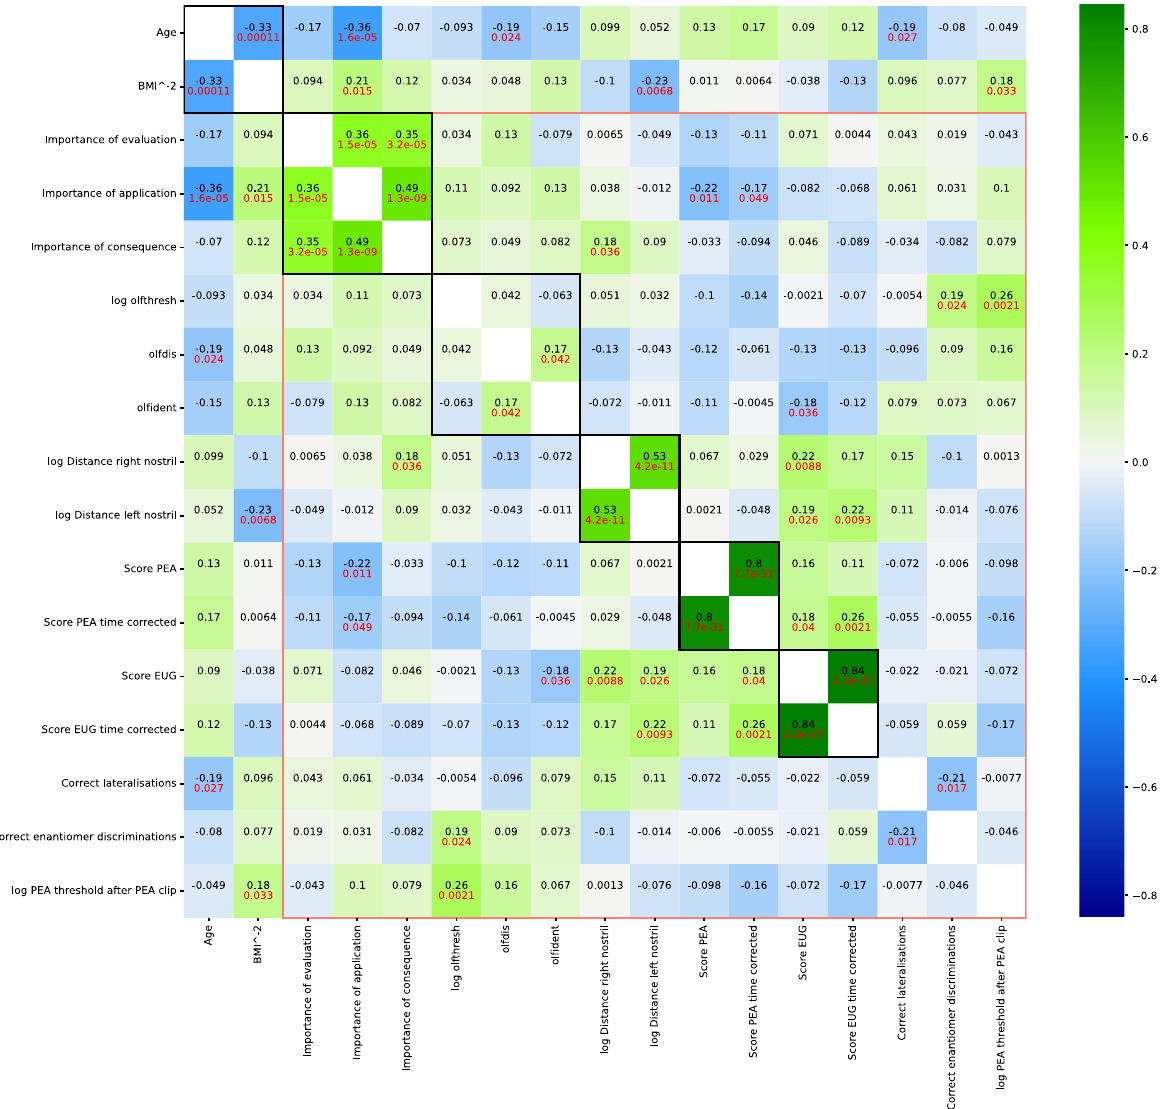
Figure 3. Correlations of olfaction-related data collected from n = 135 subjects, transformed to normal distribution and with missing values imputed. Age and BMI were additionally included. The correlation matrix is color-coded according to the strength and direction of the correlation. Each cell is labeled with the value of Pearson’s r in black numbers. If the correlation is significant, the p-value is indicated in red numbers below the correlation coefficient. The diagonal of the cor- relations of each variable with itself has been omitted. Variables belonging to the same subtest are highlighted by black rectangles to increase distinction of intra- and intertest correlations. Olfactory variables are outlined in red. Variable names, if not self- explaining: “olfthresh“ = olfactory thresh- old to phenyl ethyl alcohol (PEA), “olfdis” = score in the odor discrimination task, “olfident” = score in the odor identification task, “log Distance right/left nostril” = perception of peanut butter odor from a distance, “Score PEA/EUG” = scores in the odor sorting tasks, “Lat correct assign-